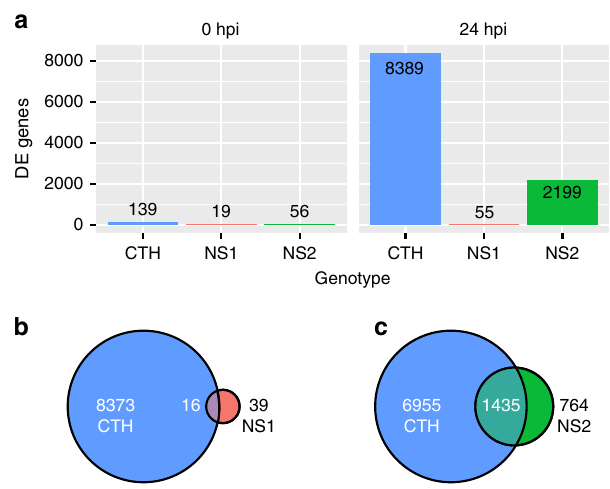
Fig. 5 Mutation in SuSr-D1 severely impacts the transcriptional response of CTH to Pgt . a Number of differentially expressed genes (DE genes) between Pgt -inoculated and mock-inoculated wild-type SuSr-D1 (CTH) and SuSr-D1 mutants (NS1 and NS2) based on FDR of 5%. b , c Venn diagrams showing overlap of DE genes between wild-type and SuSr-D1 mutants NS1 and NS2,